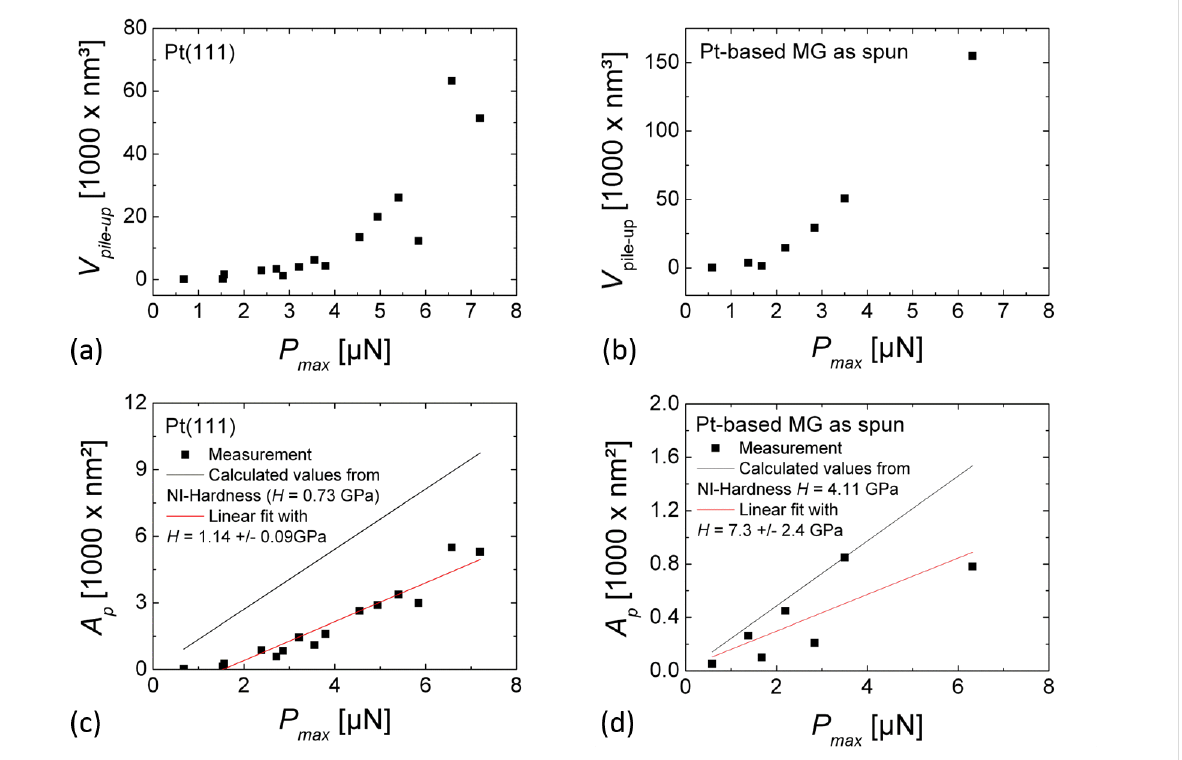
Figure 5: (a,b) Pile-up volume V pile up , (c,d) projected area A p as a function of P max for (a,c) Pt(111) and (b,d) Pt 57.5 Cu 14.7 Ni 5.3 P 22.5 metallic glass. The data points in (c) and (d) where fitted with a linear function A p = P max / H shown as a red line; for comparison the calculated values of A p as a func- tion of P max are shown as a black line for hardness values measured by